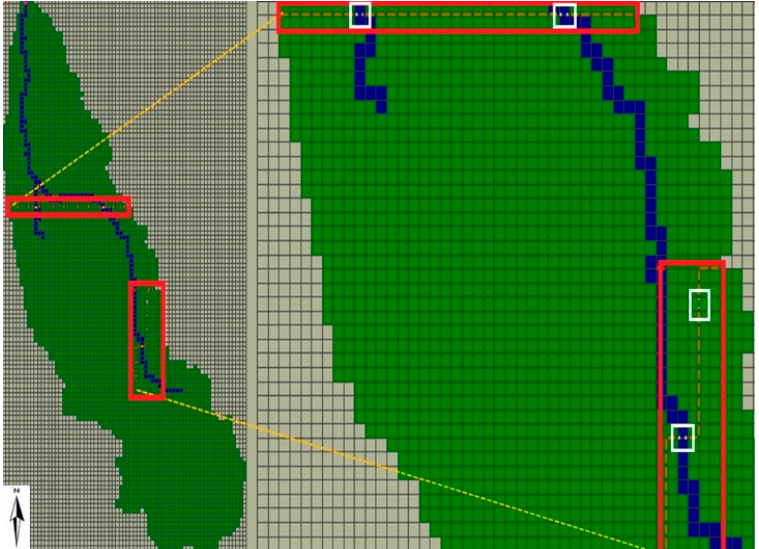
Figure 6. Location of hydraulic structures in the Santa Catalina stream basin. Embankments (brown lines) and culverts (white polygons). The basin area and stream course are in green and blue, respectively.